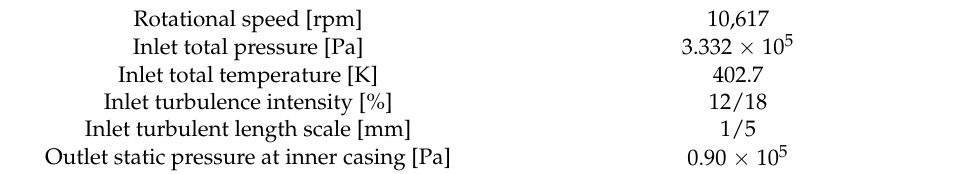
Table 2. Boundary Conditions.